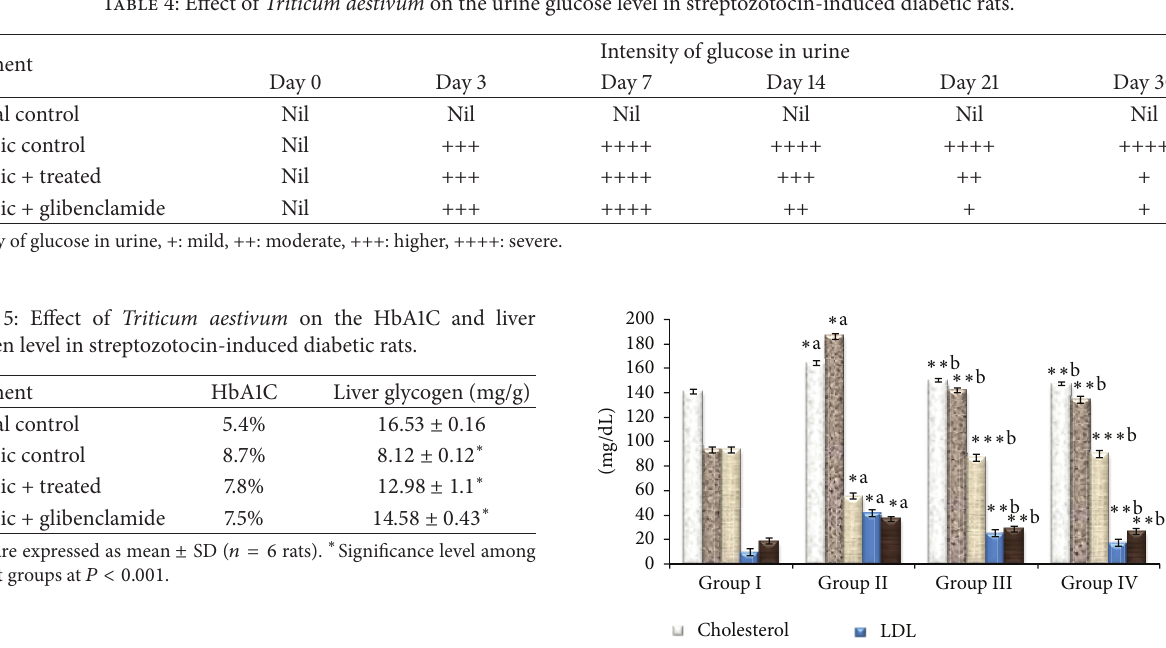
Table 3: Effect of Triticum aestivum on the blood glucose level in streptozotocin-induced diabetic rats. Treatment Normal control Diabetic control Diabetic + treated